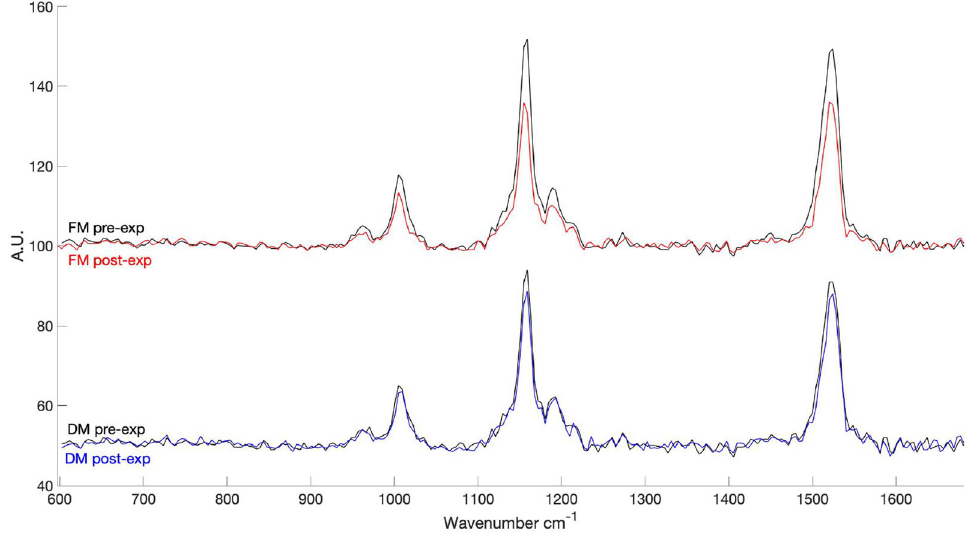
Figure 6. Above comparison between mean FM pre-exp. Raman spectra (black line) and mean FM post-exp. Raman spectra (red line). Below) comparison between mean DM pre-exp. Raman spectra (black line) and mean DM post-exp. Raman spectra (blue